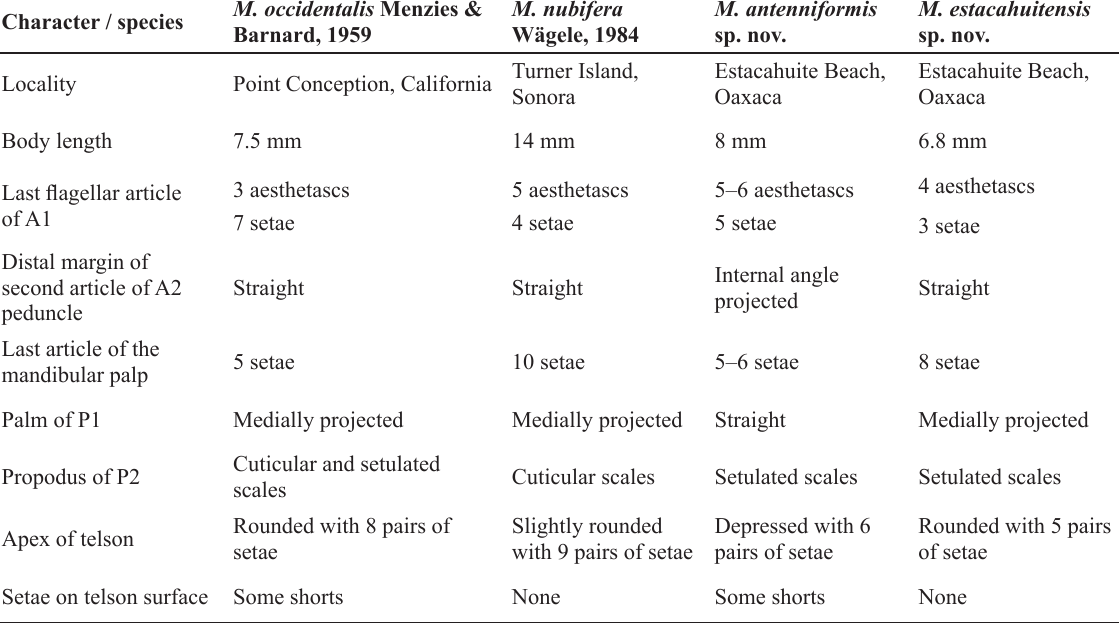
Table 1. Comparison between the species of Mesanthura Barnard, 1914 recorded in the Mexican Pacific and Mesanthura antenniformis sp. nov., Mesanthura estacahuitensis sp. nov. from